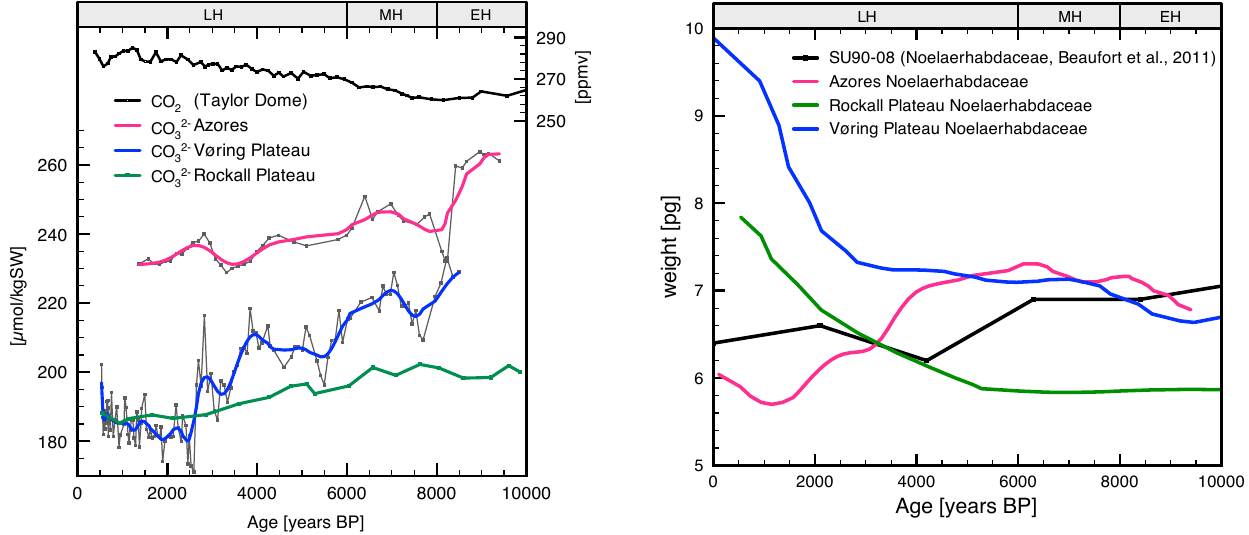
Fig. 3. Holocene carbon dioxide concentration from Taylor Dome ice core data (Indermühle et al., 1999; black line) and Holocene carbonate ion concentration of Azores (red line), Rockall Plateau (green line) and Vøring Plateau (blue line). Bold lines are smoothed (by factor a 4), and grey thin lines represent original data.